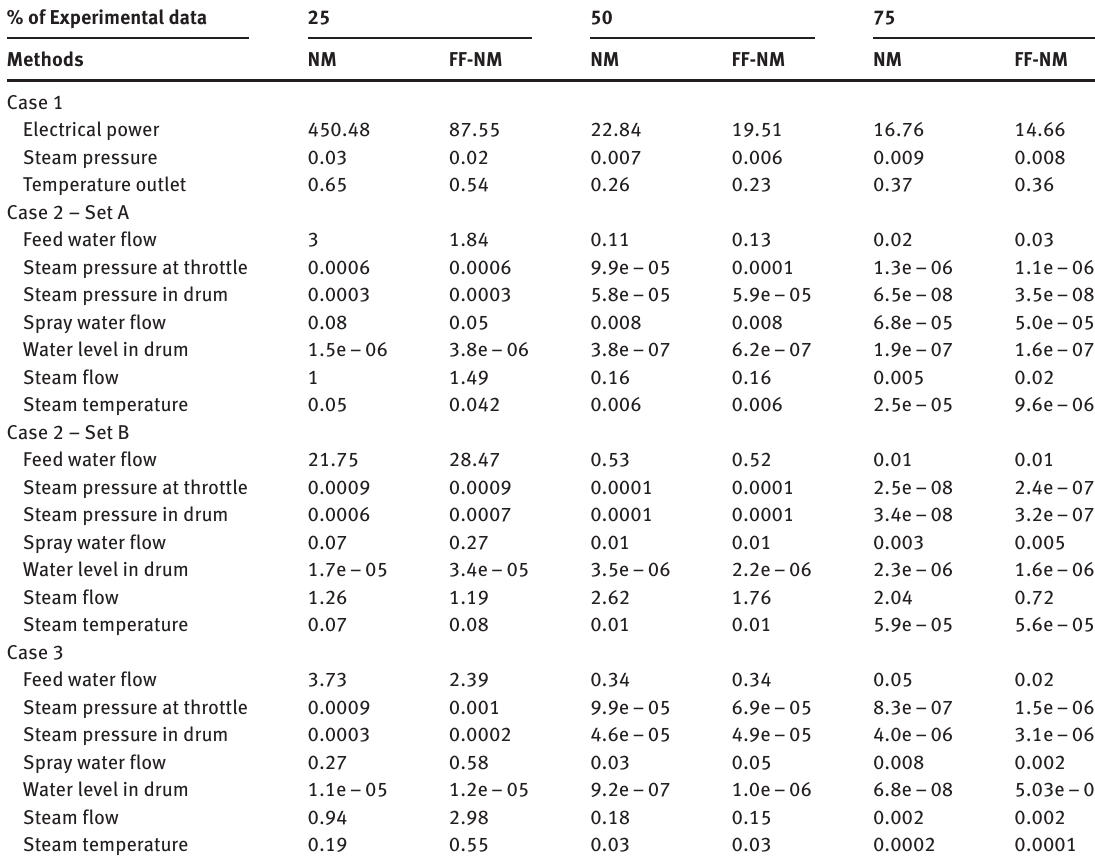
Table 5: Error Deviation of Various Design Models with the Actual Boiler Performance. % of Experimental